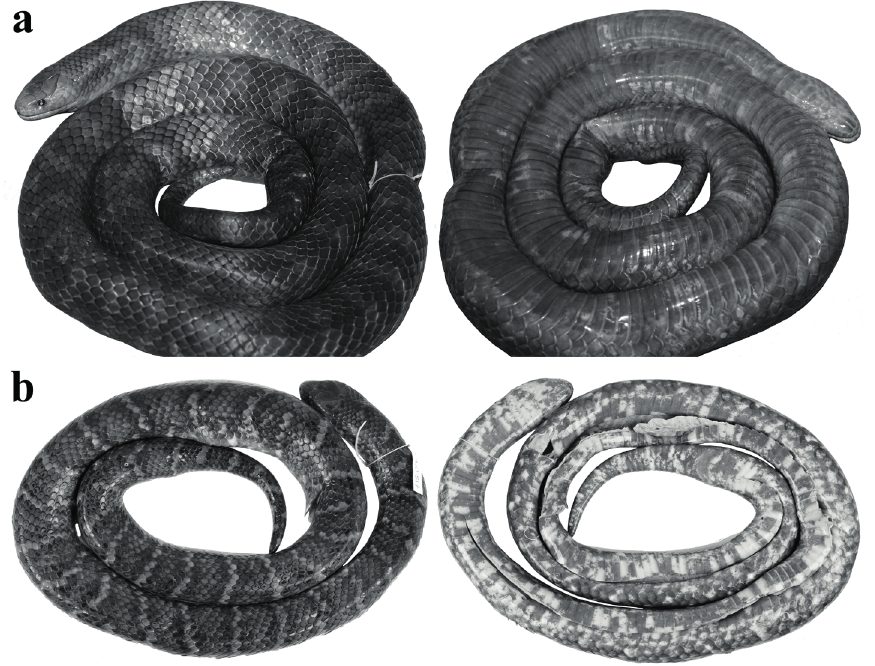
Figure 3 - dorsal (left) and ventral (right) views of body of the paratype of Atractus atlas (dHmeCN 2972 - A, SVl 735 mm, Cl 90 mm) and the holotype of Atractus touzeti (FHGO 517 - B; SVl 1035 mm, Cl 118